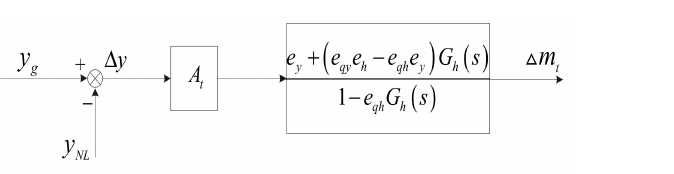
Figure 2. Hydro-turbine model under load